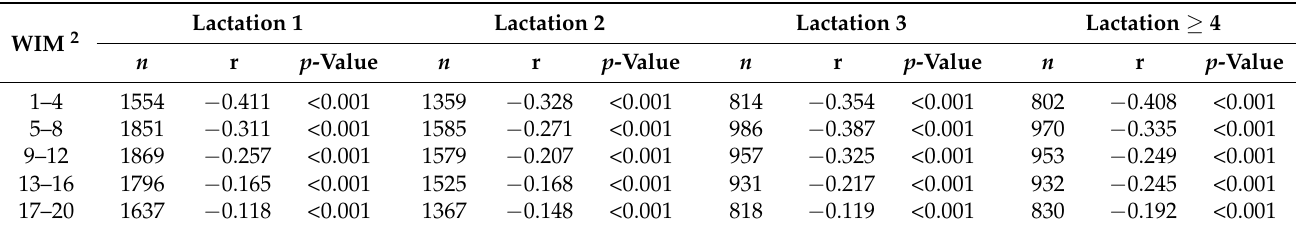
Table 2. Partial correlations coefficients between fat-to-protein ratio in milk (FPR) and daily energy balance (EB, MJ